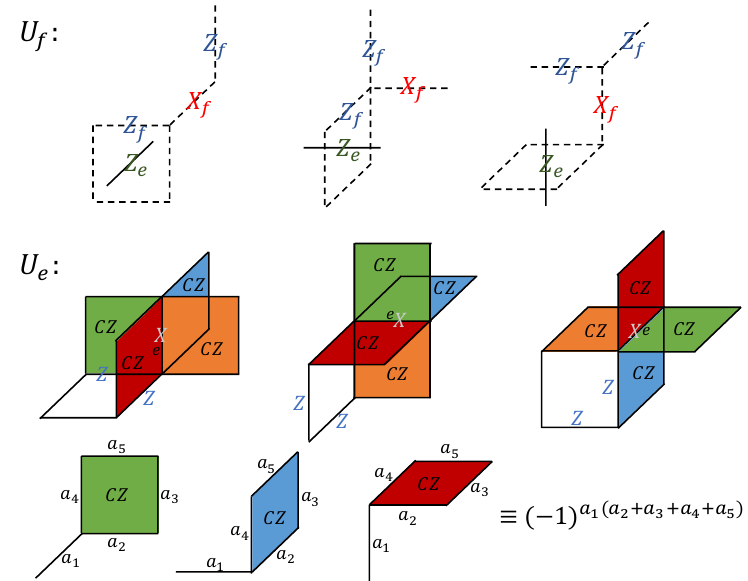
Figure 2: The excitations in the boundary state of the beyond group cohomology invertible phase without symmetry in (4 +